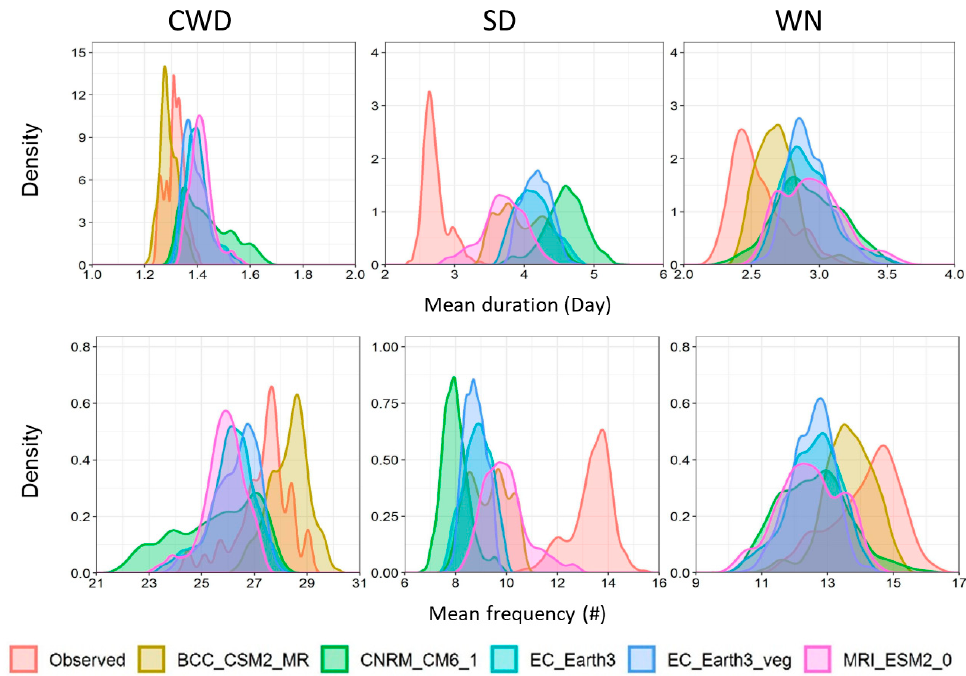
Figure 6. Kernel density curves of mean duration and mean frequency of CWD, SD, and WN for the 1983–2014 period.